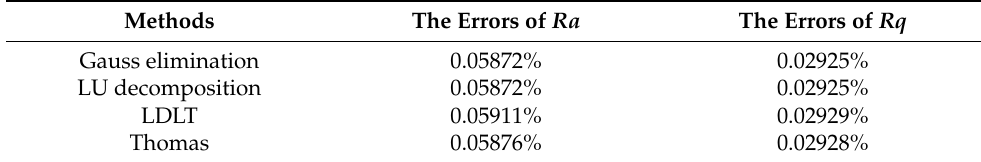
Table 4. The errors between the roughness values obtained by the four algorithms and the roughness values obtained by the spline filter in the Mountains ® software.